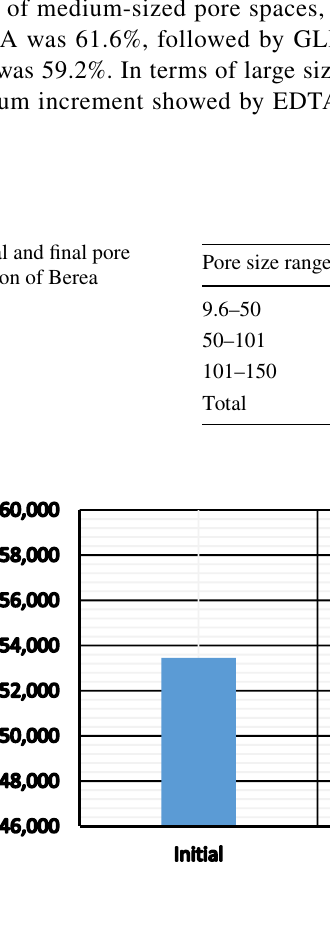
Fig. 3 Change in Number of pore space (Colton) Table 6 Colton sandstone Initial and final pore size